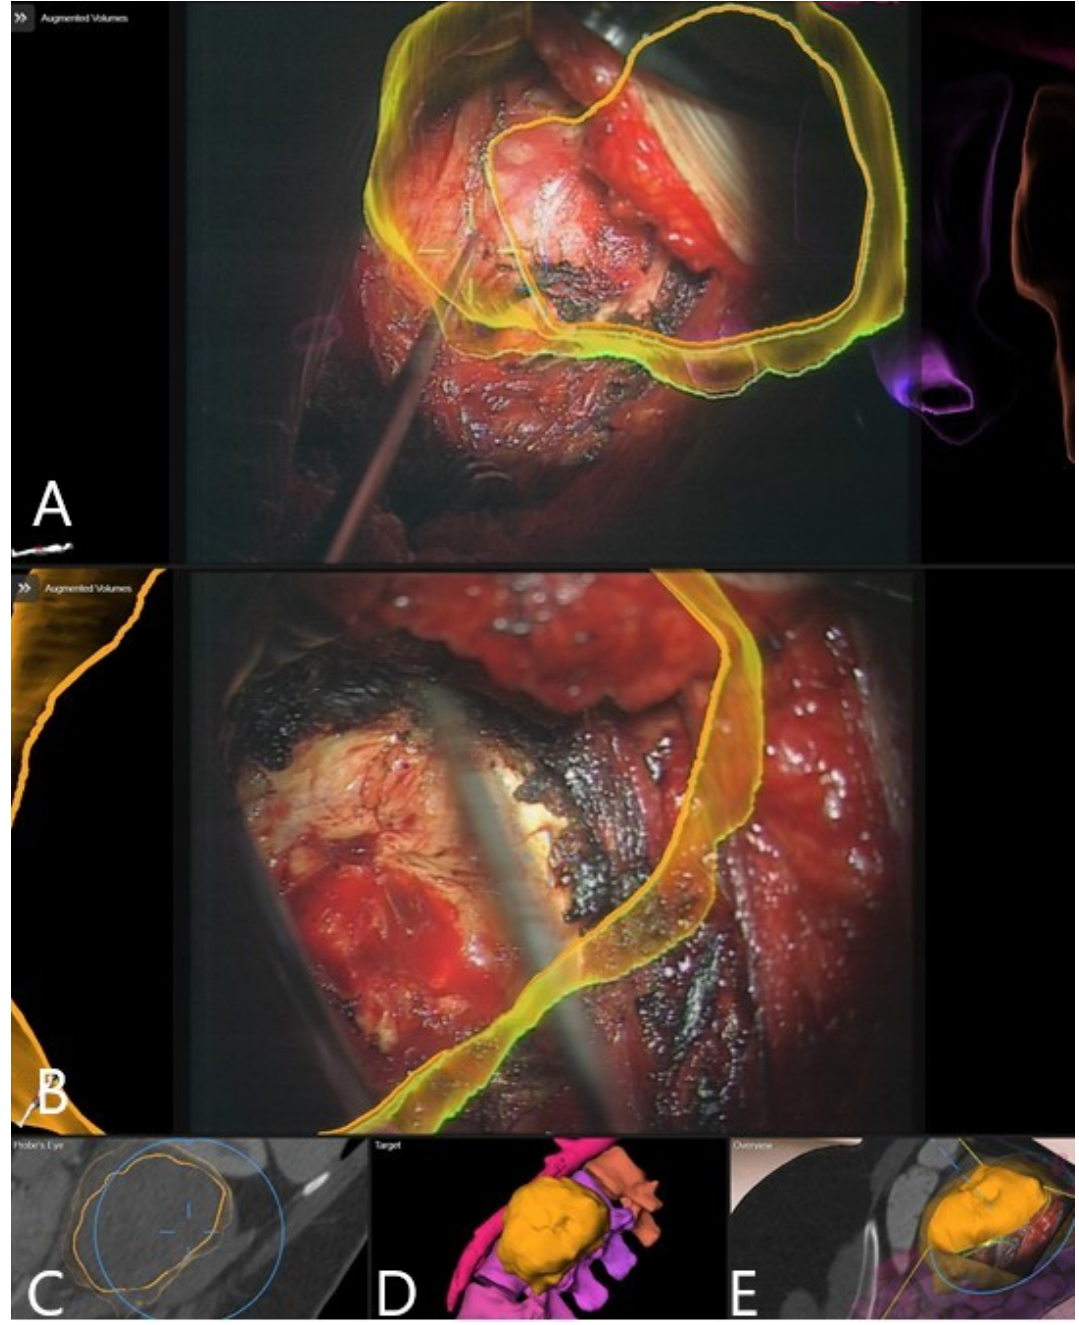
Figure 6. Same patient as in Figure 5 (patient no. 9). Microscope-based AR visualizing the tumor outline. ( A ) At the beginning of the tumor resection. ( B ) During the course of resection, with ( C ) Probe’s-eye view; ( D ) target view visualizing the displayed AR objects. ( E ) A 3D rendering of the iCT images illustrating how video frame is placed in relation to the image data.